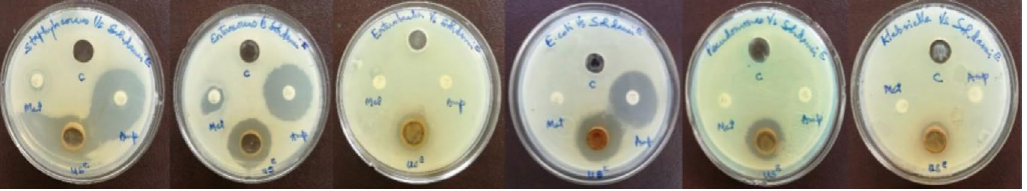
Fig. 5. Plates of Well diffusion assay showing antibacterial activity of G. pedunculata ethanol extract on UTI clinical bacterial isolates.(C=control well filled with ethanol; US=well filled with EEGP; Met = methicillin disc; Amp=ampicillin